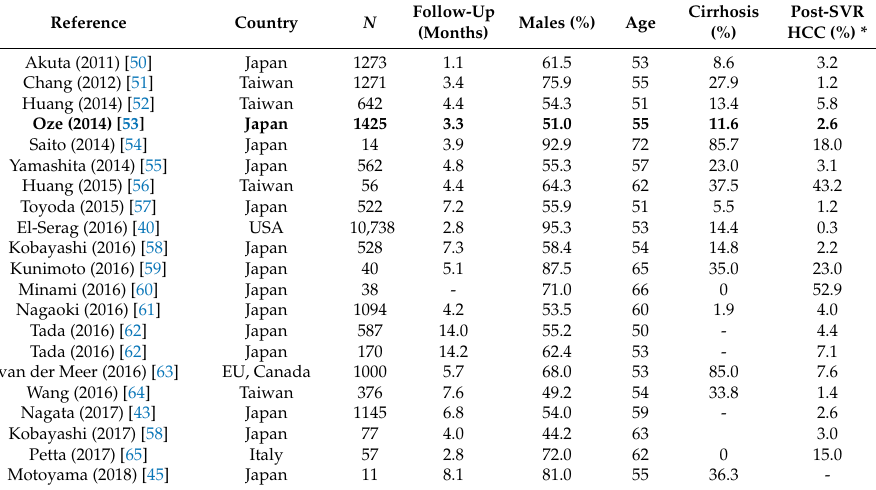
Table 1. Studies reporting incidence of hepatocellular carcinoma following post-sustained virological response in interferon-treated chronic hepatitis C patients (adapted from Baumert et al., 2017 [49]). Prospective studies are indicated using bold text.